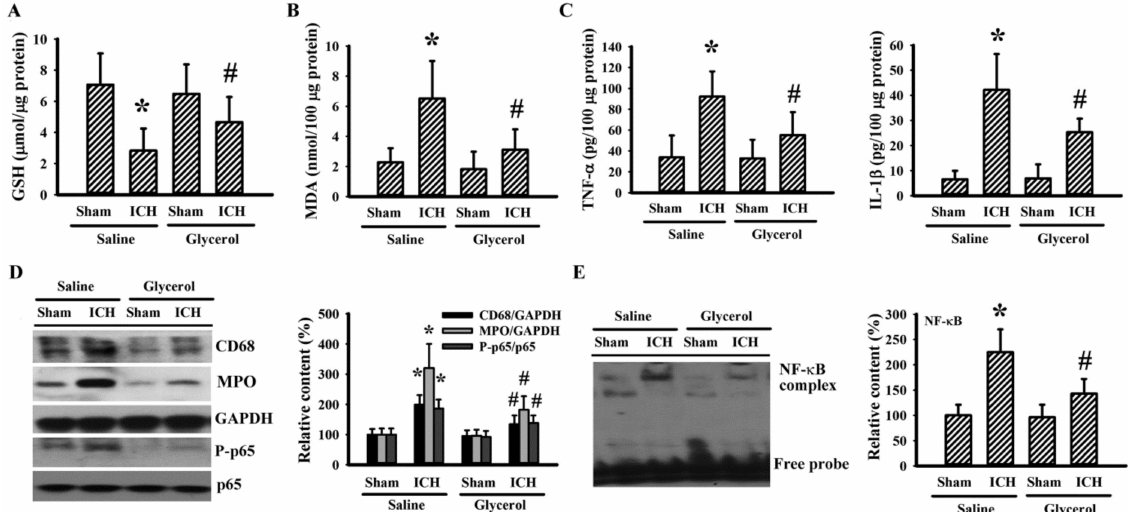
Figure 3. Glycerol alleviated hemorrhagic stroke oxidative stress and neuroinflammation. ICH and sham rats were intraperitoneally injected with saline or glycerol and housed for an additional 24 h. The contents of GSH ( A ) and MDA ( B ) in the ipsilateral striatal tissues were measured. ( C ) Proteins were extracted from the ipsilateral striatal tissues and subjected to ELISA for the measurement of TNF- α and IL-1 β . ( D ) Proteins were extracted from the ipsilateral striatal tissues and subjected to Western blot assay with indicated antibodies. ( E ) Nuclear proteins were extracted from the ipsilateral striatal tissues and subjected to EMSA for the measurement of NF- κ B DNA-binding activity. Representative blots and the quantitative data are shown. Specific protein content was normalized with the corresponding total protein or GAPDH. * p < 0.05 vs. sham/saline and # p < 0.05 vs. ICH/saline, n =